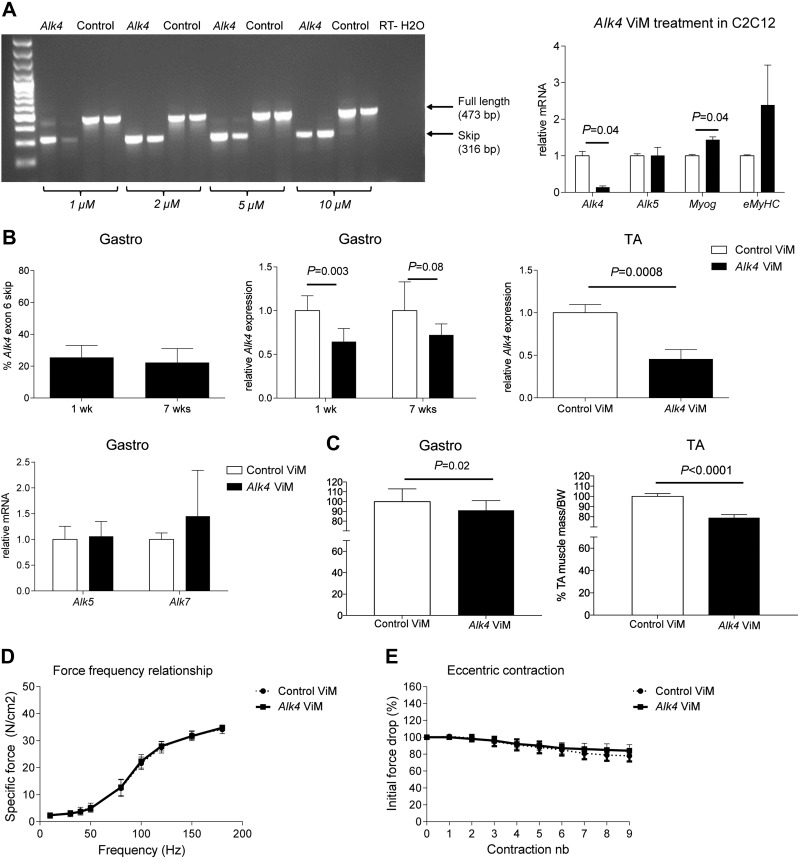
Effect of Alk4 down-regulation with ViM in C2C12 cells, mdx gastrocnemius and tibialis anterior muscles. A) ViM targeting exon 6 of Alk4 was added to cells without any transfection reagent at 1–10 μM for 72 h, and exon skip efficiency was measured with RT-PCR. Alk4 and Alk5 transcripts and myogenic gene expression were measured with qPCR of samples treated with 1 μM Alk4 and control ViM. B) Percentages of exon skipping of Alk4 or control ViM-injected gastrocnemius muscles after 1 and 7 wk of treatment were measured. qPCR was performed to measure Alk4 full-length transcript of Alk4 or control ViM-injected gastrocnemius and tibialis anterior muscles. Specific Alk4 transcript down-regulation was measured in gastrocnemius muscles after 1 (n = 6) and 7 (n = 6) wk of treatment and in tibialis anterior muscles after 7 wk (n = 4) of treatment. qPCR was performed to measure Alk5 and Alk7 transcripts of long-term Alk4 or control ViM-injected gastrocnemius muscles. No differences in either transcript were detected after the treatment. C) Weighing of the Alk4 ViM-treated gastrocnemius muscles showed a 10% decrease, and tibialis anterior muscles showed a 20% decrease relative to control ViM. Muscle weights were normalized to the body weights at the endpoint of the experiment. D) Force vs. frequency for the tibialis anterior muscles treated intramuscularly with Alk4 ViM and contralaterally with control ViM for 7 wk (n = 6). Each data point represents the force measured at each frequency. No significant differences in the total force were measured between control and Alk4 ViM-treated muscles. E) Relative changes in tetanic force during 9 cycles of eccentric contraction in tibialis anterior muscles (n = 6) treated intramuscularly with Alk4 ViM and in contralateral muscles treated with control ViM for 7 wk. The tetanic tension developed during the second cycle was taken as 100%. No significant differences in the initial force decrease between control and Alk4 ViM-treated muscles were measured. Error bars, sd (A–C) and sem (D, E).